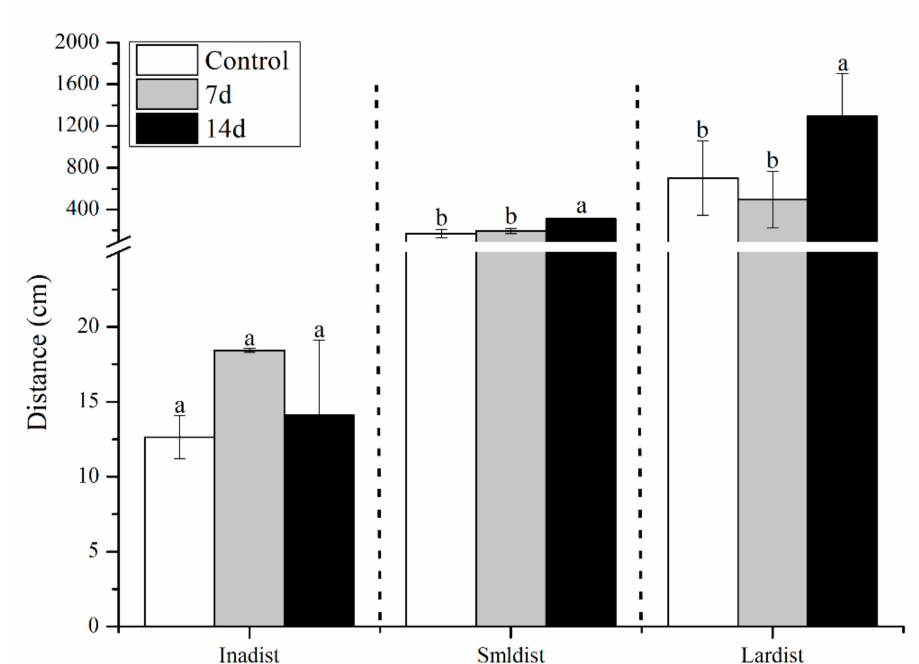
Figure 3. Effects of 7 and 14 days of the UCS protocol on inadist, smldist, and lardist in the rare minnow. Data are expressed as mean ± SE (n = 18). The different letters in the bar indicate significant differences between the two groups ( p < 0.05).